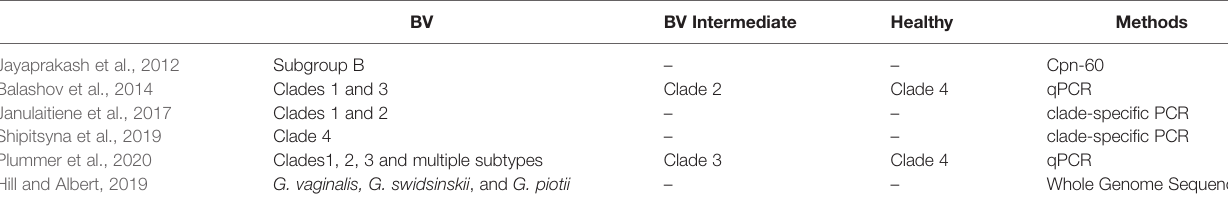
TABLE 2 | Different Gardnerella subtypes predict distinct BV clinical